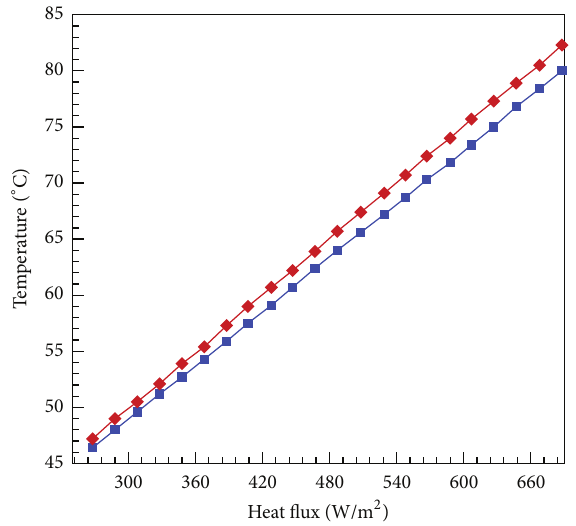
Figure 4: Temperature difference between inner and outer surface of the tube.